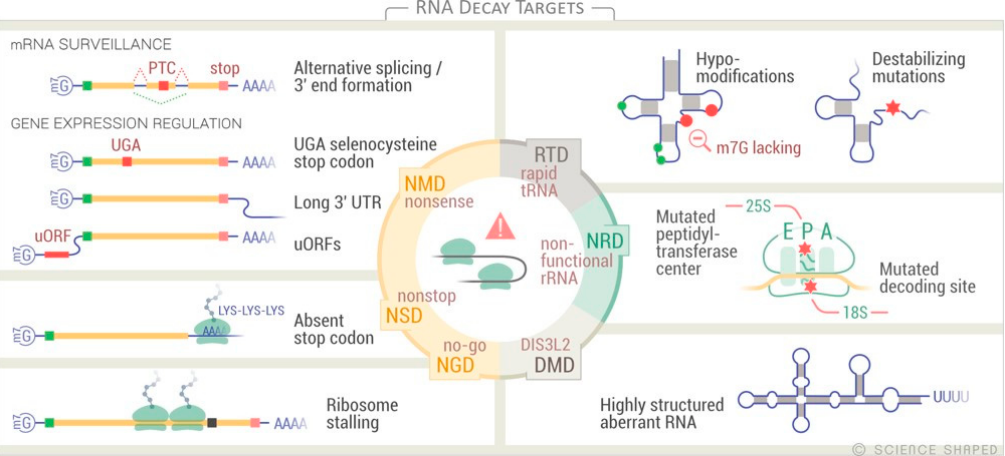
Figure 4. RNA decay target features in eukaryotes. Summary of features for the decay targets. NMD, nonsense-mediated mRNA decay; NGD, no-go decay; NSD, non-stop decay; NRD, non-functional rRNA decay; RTD, rapid tRNA decay; DMD; DIS3L2-mediated decay.